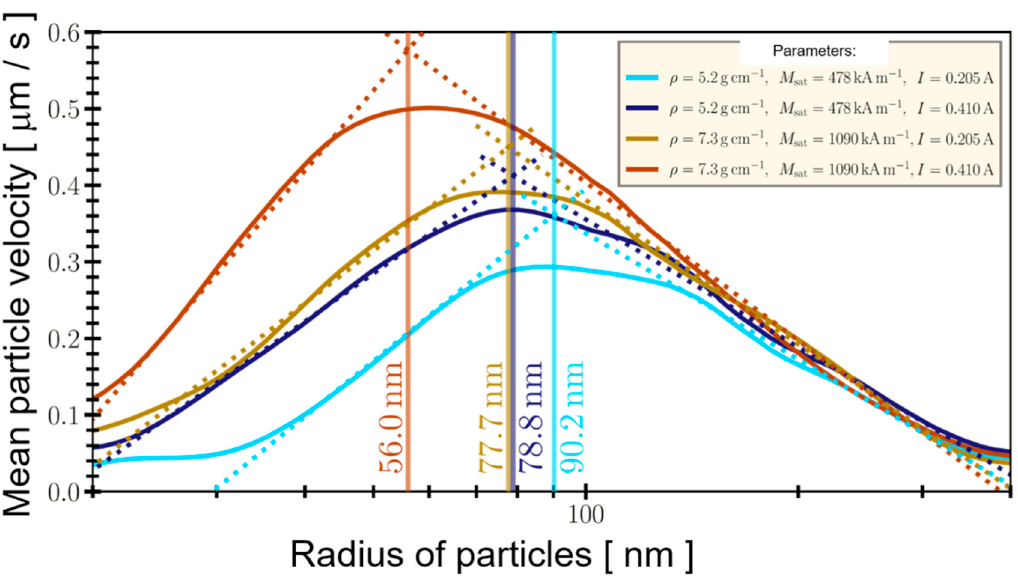
Figure 11. Simulated mean particle velocity as a function of the radius of the particles for Magnetite ( ρ = 5.2 g/cm, M s = 478 kA/m) and Co 2 FeSi ( ρ = 7.3 g/cm, M s = 1090 kA/m). Geometry of the ratchet with six conduction paths, for each path: a = 41 µ m, h = 0.1 µ m, b = 200 µ m, s = 2.5 µ m, k = 20 µ m. Two current flows through each conductor are tested, I = 0.205 A and I = 0.410 A. The switching times are τ on = 11.5 s and τ off = 3.5 s. The dotted lines serve as guidelines to the eyes indicating the positions of the maxima of the mean particle velocities.